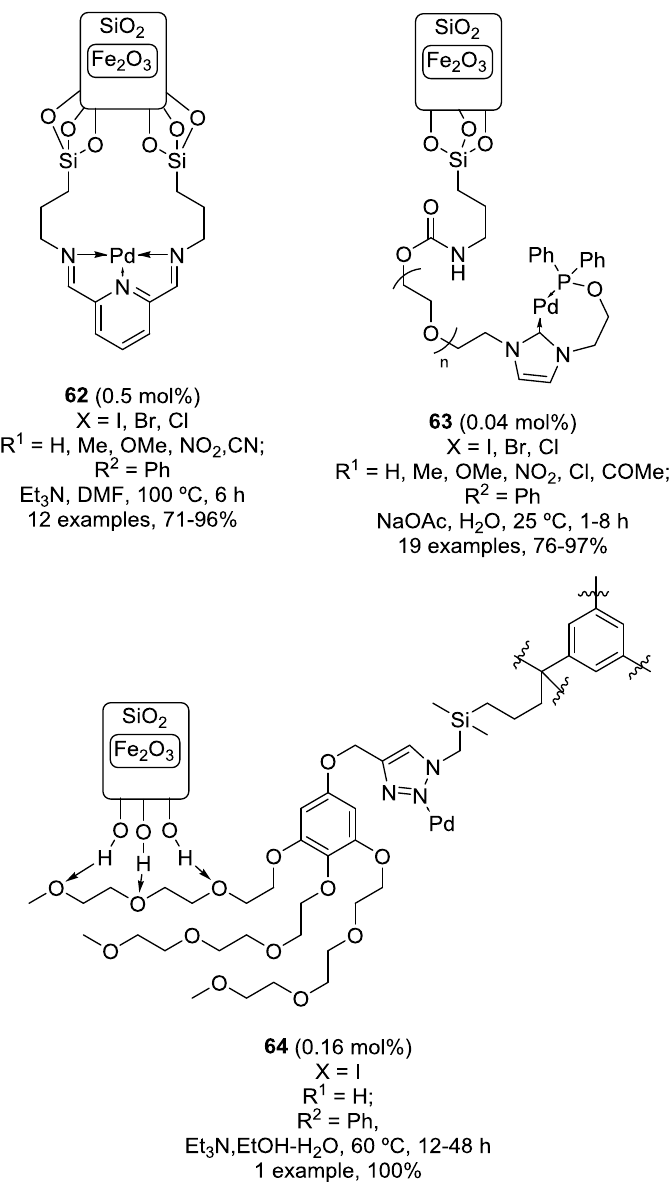
Figure 20. Maghemite coated-grafted palladium catalysts for the Sonogashira reaction. Conditions, substrate scope and yield range (Scheme 2).